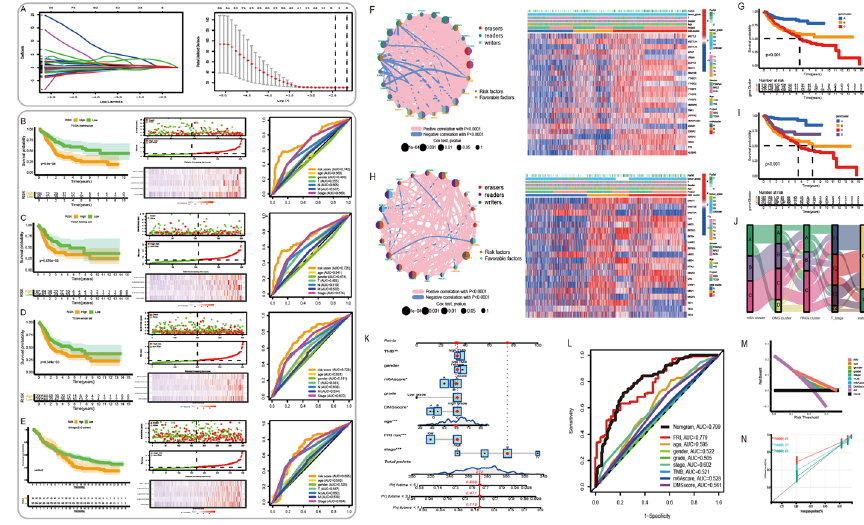
Fig. 6 Establishment of a 5‑lncRNA signature and a comprehensive nomogram. A Illustration for LASSO coefficient profiles of 44 prognostic lncRNAs. B – E The performance of a 5‑lncRNA signature in Training group ( B ), testing group ( C ), TCGA cohort ( D ), IMvigor210 cohort ( E ). F , H The interaction between m6 A regulators ( F ) and DNA methylation regulators ( H ). G – I Kaplan–Meier analyses. J ggAlluvial diagram. K